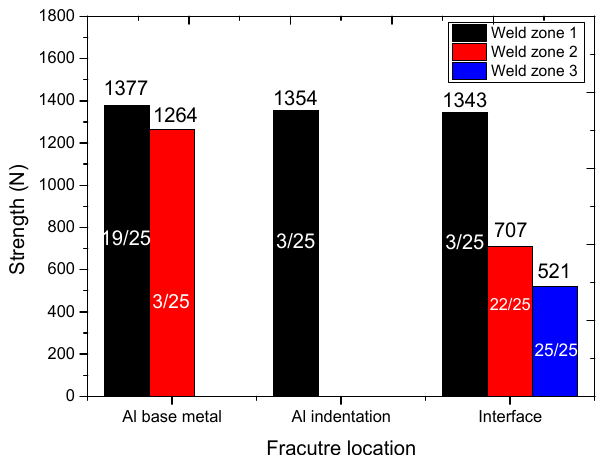
Figure 13. Average strength values according to fracture location.